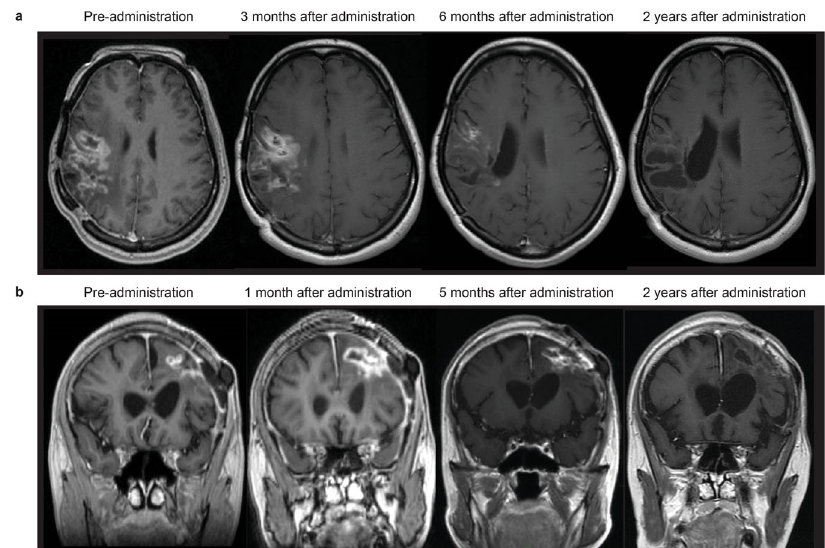
Fig. 4 Serial MRI fi ndings of two patients who showed responses. a Patient #3. After receiving two doses of G47 Δ (3 × 10 8 pfu/dose), a drastic decrease in size of the target lesion was observed at 6 months and a complete response was observed at 24 months, leaving areas of porencephaly. b Patient #4. After receiving two doses of G47 Δ (1 × 10 9 pfu/dose), the entire target lesion increased in contrast enhancement size at 1 month, but then gradually decreased at 5 months, and ended with a marked decrease at 2 years. A portion of the lesion continued to show contrast enhancement, so this patient was considered PR. The lesion remains stable and this patient survives for >11 years.